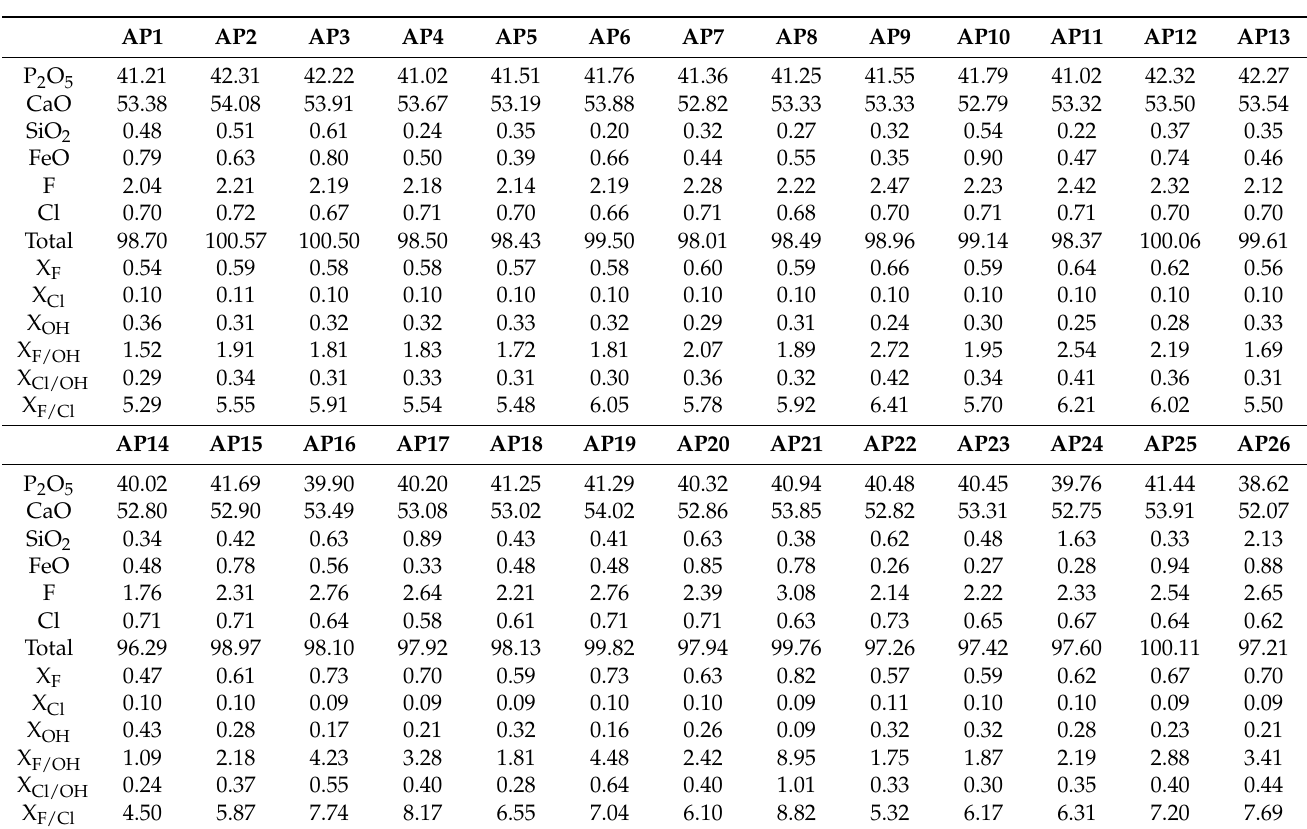
Table 3. The major and volatile element analyses of the apatite microphenocrysts